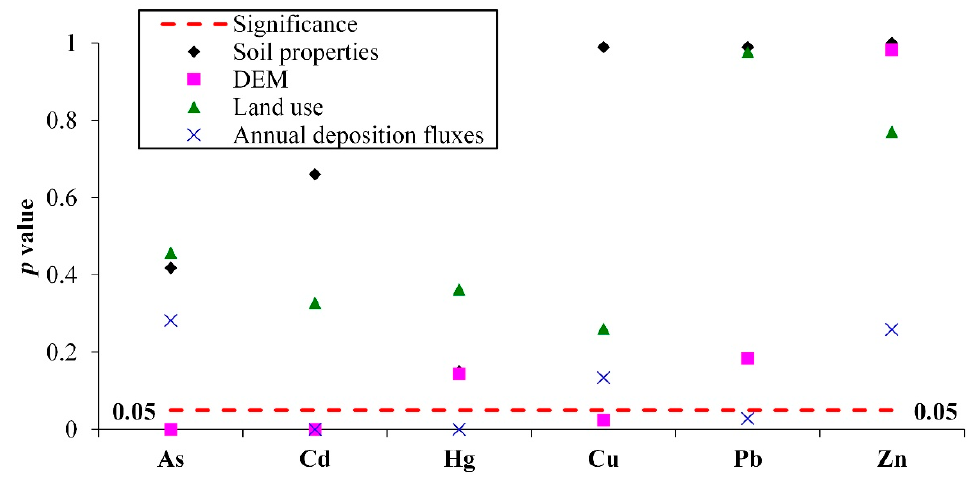
Figure 4. The p values of influencing factors on heavy metal concentrations at the single-object level.